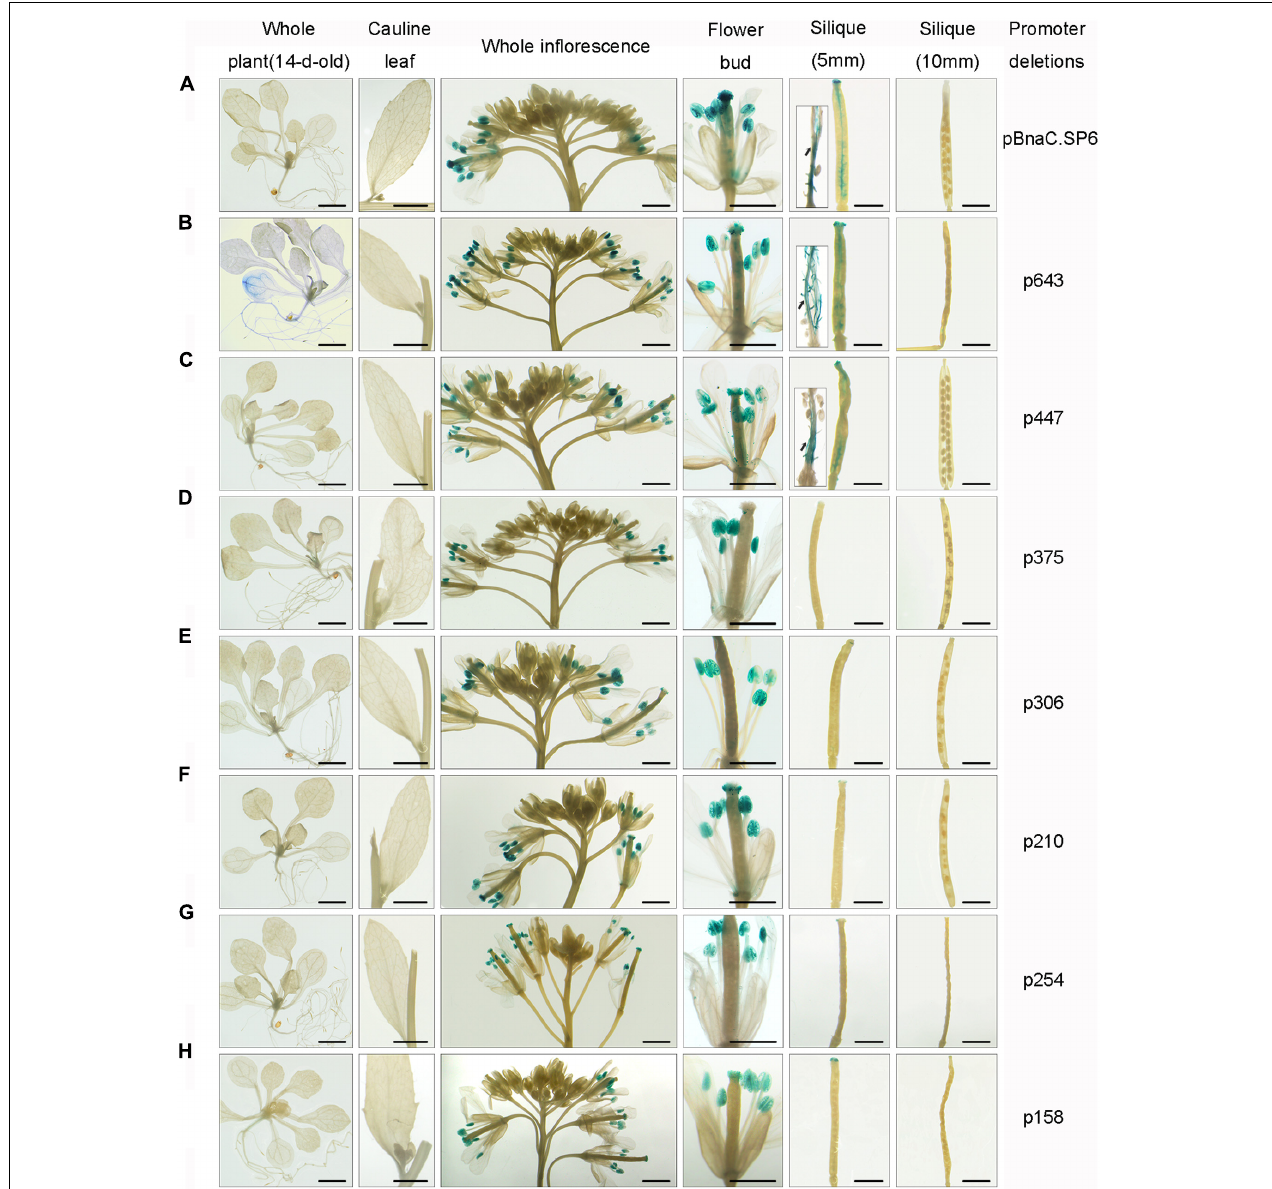
FIGURE 2 | Histochemical GUS assay of pBnaC.SP6 and its deletions in transgenic Arabidopsis . GUS expression was analyzed in various tissues of transgenic Arabidopsis , namely whole plant (14-d-old), cauline leaves, whole inflorescence, flower buds, and siliques (5 and 10 mm). Black arrows indicate the silique septum. Bars, 1 mm (whole plant, cauline leaves, whole inflorescence, and siliques); 500 µ m in the case of flower buds. (A–H) pBnaC.SP6 and its truncations (p643, p447, p375, p306, p210, p254, and p158) are shown, respectively.